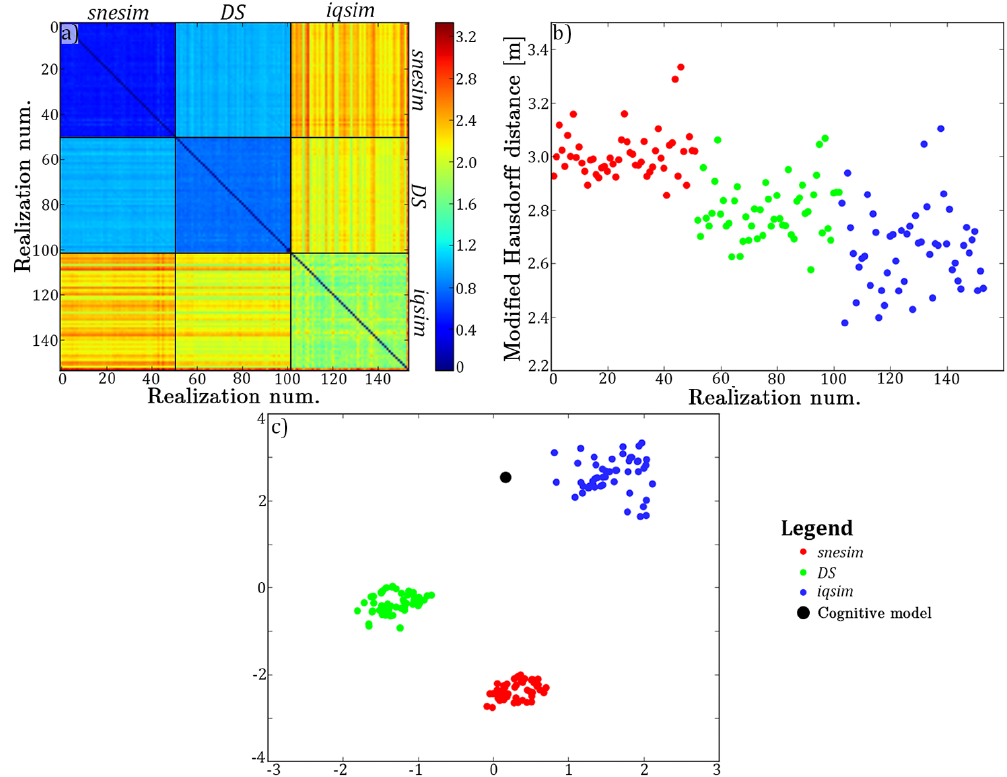
Figure 9. The D MH results presented without and with dimensional reduction. (a) The full modified Hausdorff distance ( D MH ) matrix showing the distances between individual realizations and between individual realizations and the cognitive hydrostratigraphic model. The last column and row of the distance matrix of (a) represent the distances between the realizations and the cognitive model. (b) shows a scatterplot of these distances between the realizations and the cognitive model, revealing greater detail than can be seen with the naked eye from the D MH matrix itself. (c) shows the 2-D t-SNE plot of the D MH matrix.